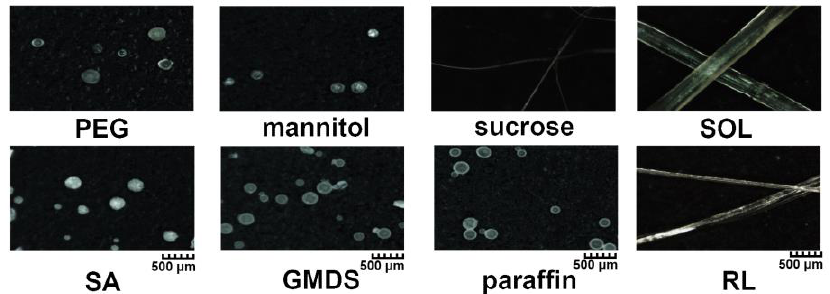
Figure 3. Morphology of the products composed of polyethylene glycol (PEG), mannitol, sucrose, Soluplus ® (SOL), stearic acid (SA), glycerol monostearate/distearate (GMDS), paraffin, and Eudragit ® RL PO (RL) prepared via MCA.